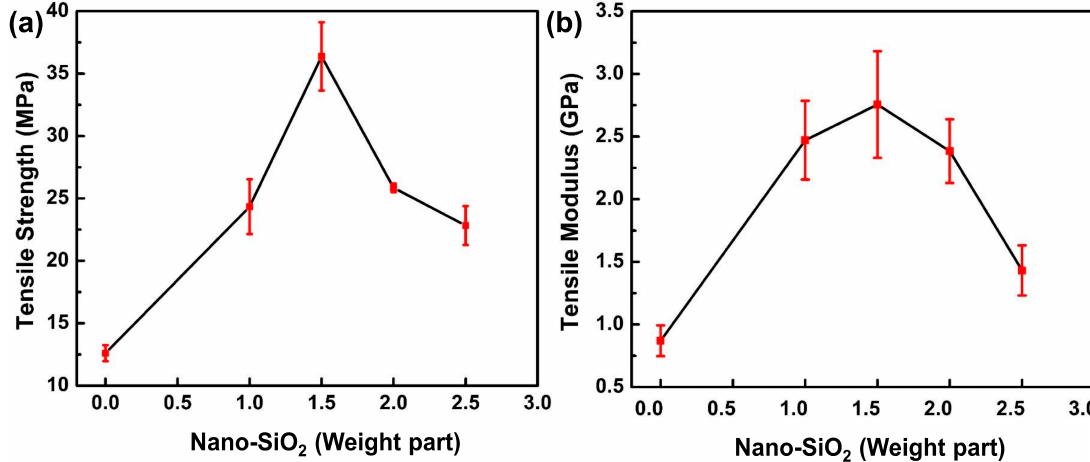
Figure 9. ( a ) Tensile strength and ( b ) tensile modulus vs nano-SiO 2 content for